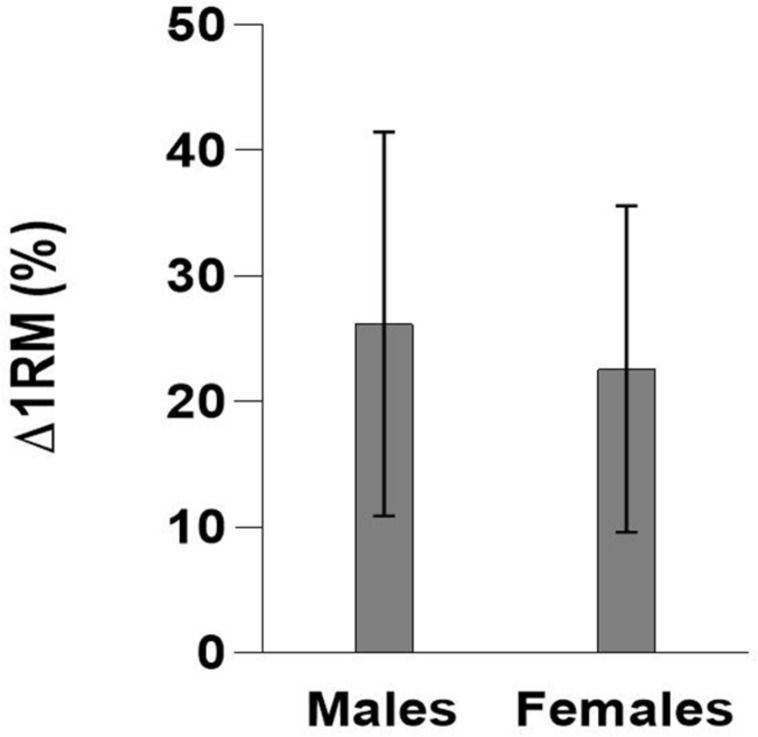
Mean improvements (%) in one-repetition maximum (Δ1RM) ± standard deviation (SD) following an 8-week maximal strength training program by gender.